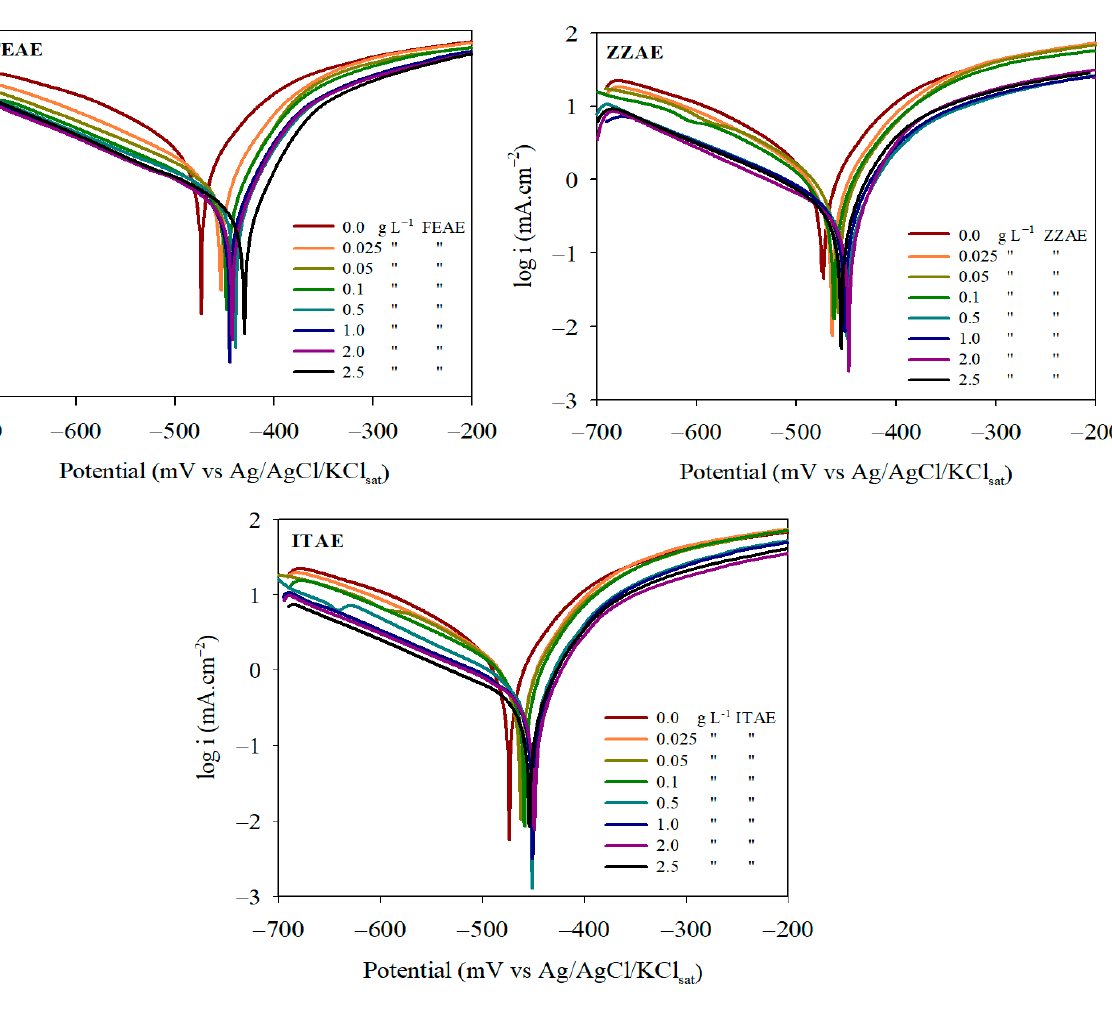
Figure 2. PDP curves for mild steel corrosion in 2 M H 3 PO 4 with and without different concentrations of the studied plant extracts at 30 °C.